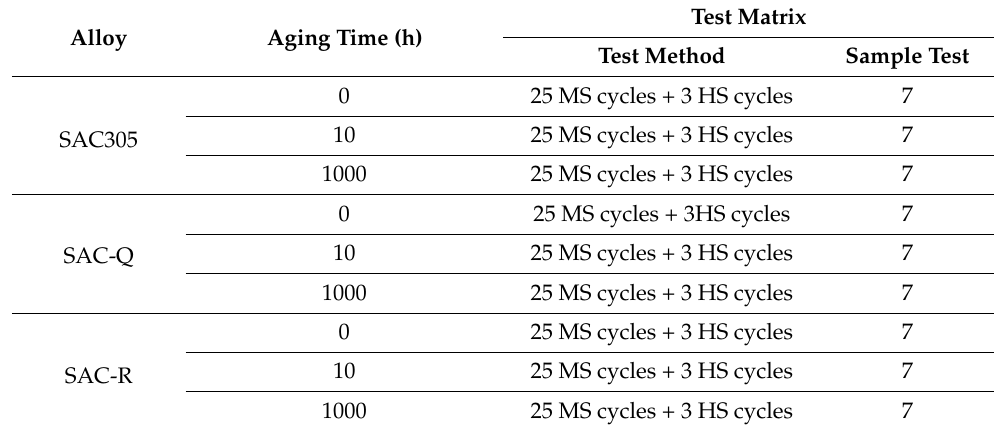
Table 3. Varying amplitude test plan of aged solder alloys aged for 0, 10, 1000 h. Alloy